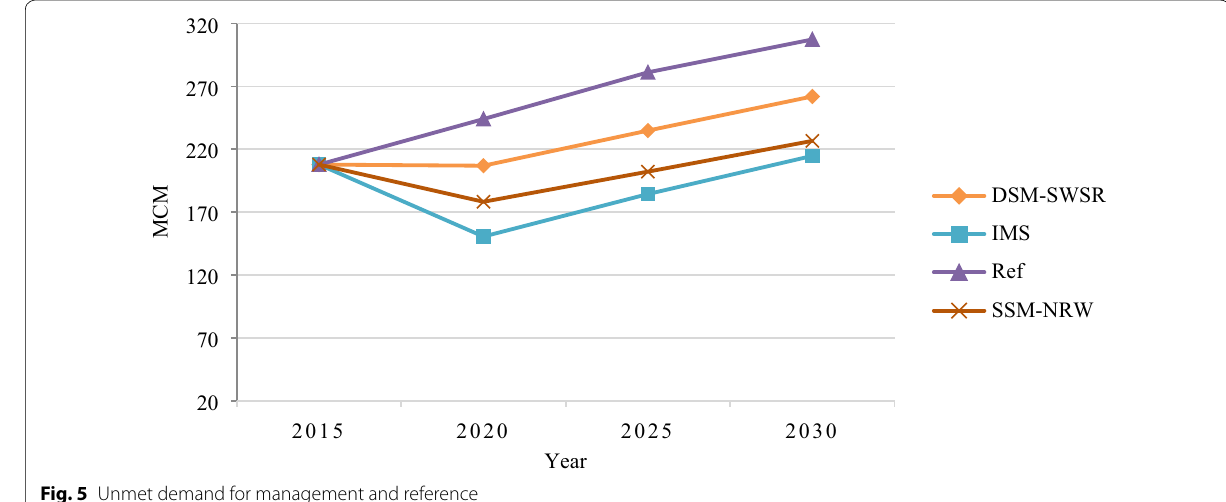
Fig. 5 Unmet demand for management and reference